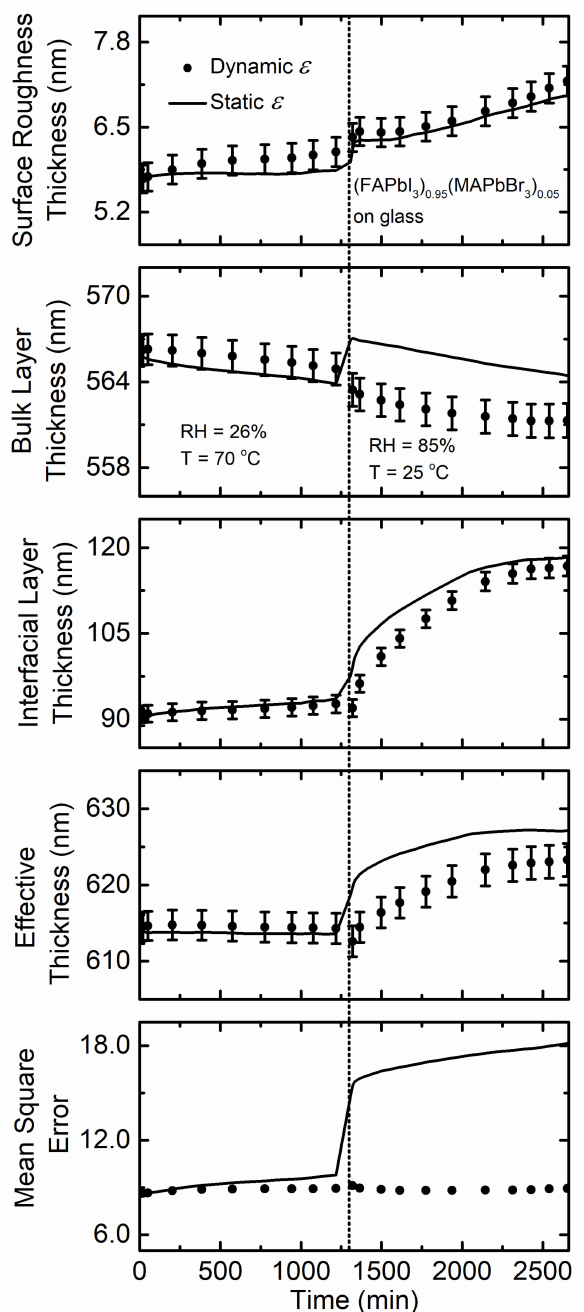
Figure 9. Surface roughness thickness, bulk layer thickness, interfacial layer thickness, effective perovskite thickness, and the quality of fit between the model and experimental ellipsometric spectra in the term of mean square error as functions of time for thin film (FAPbI 3 ) 0.95 (MAPbBr 3 ) 0.05 deposited on soda lime glass when exposed to 26% RH at 70 ◦ C then 85% RH at 25 ◦ C. Values obtained assuming the initial spectra in ε (time = 0 min; static) prior to exposure are represented by a solid line, and spectra in ε fit at each time point (dynamic) are represented by solid circles. The vertical dotted line marks when the temperature and humidity are changed. RH is introduced at 5